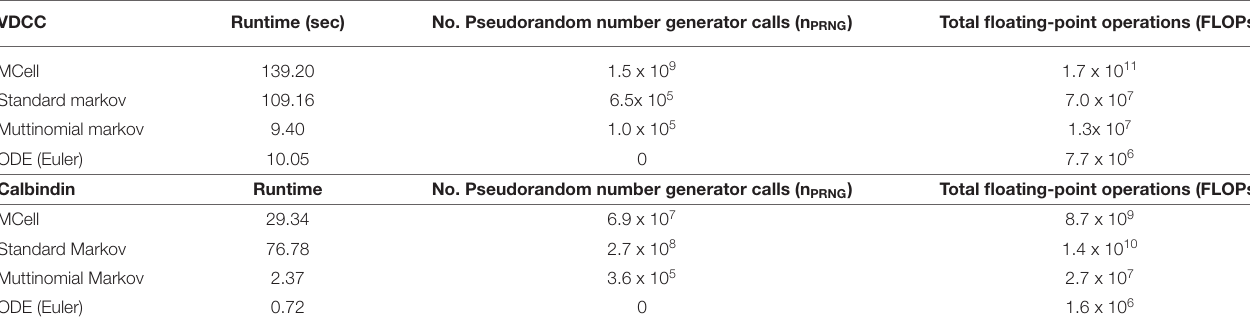
TABLE 1 | Benchmarks for different simulation types for both voltage-dependent calcium channel and calbindin binding